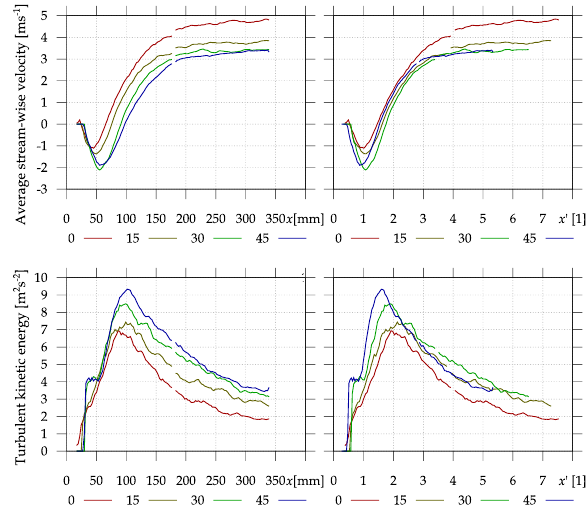
Fig. 3. Top : the development of of the average stream-wise ve- locity on the wake axis. The drop at x = 180mm is caused by gluing the data from the two cameras. Bottom : the development of the turbulent kinetic energy along the wake axis. Color de- picts the angle of attack: red for 0 ◦ , yellow for 15 ◦ , green for 30 ◦ and blue for 45 ◦ . Left : the distance x is in [mm] counted from the axis of the obstacle. Right : the stream-wise distance x ′ is normalized by the crosssectional size of the obstacle, i.e. x ′ = ( x / a ) · cos α , where a = 45mm is the side of the studied aluminum